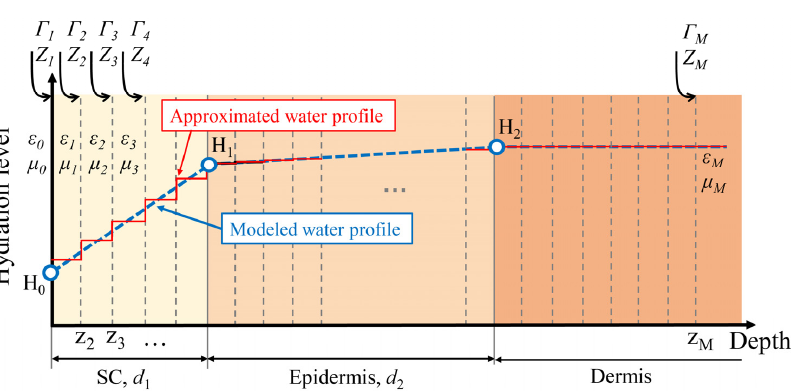
Figure 6. Schematic diagram showing the water profile in skin and the derivation of the reflection of a plane wave by a slab of stratified permittivity and permeability. The blue curve is the modeled water profile defined by H 0 , H 1 , H 2 and d 1 , d 2 . The red curve is the approximated water profile used to estimate the permittivity in each layer.